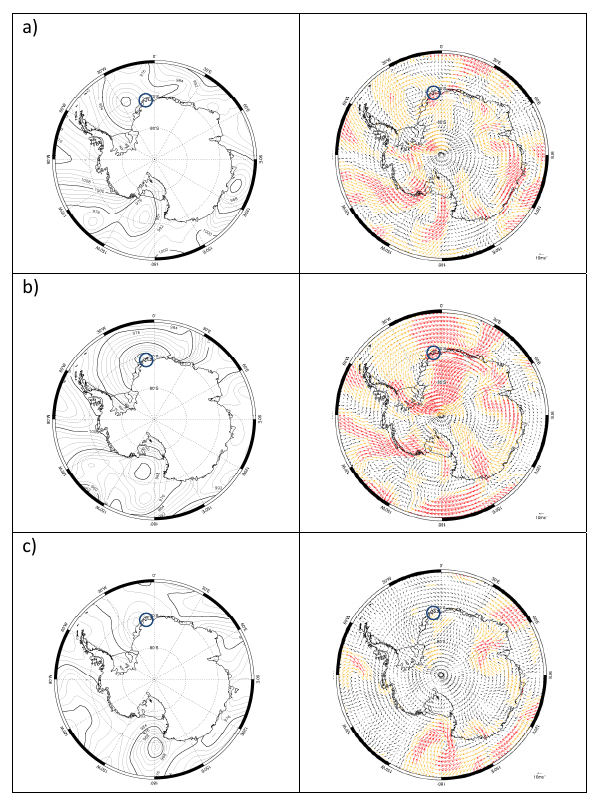
Fig. 19. ERA-40 mean sea level pressure charts and charts of 10- m wind speed vectors that coincide with the high altitude ozone depletion events discussed by Frieß et al. (2004). Maps of BrO from the GOME satellite (see Frieß et al., 2004) show enhanced BrO associated with the low pressure systems shown here. Neumayer is marked by the blue circle on the